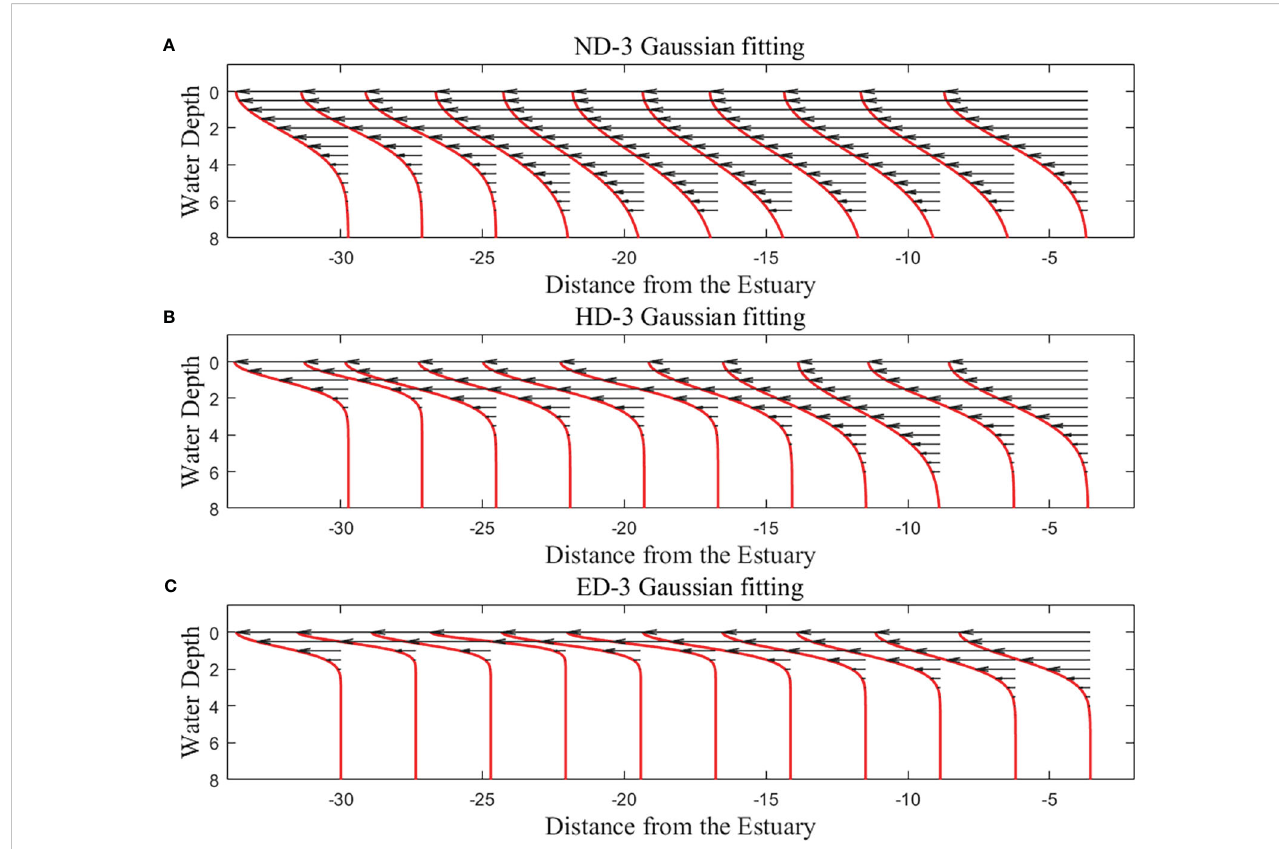
FIGURE 6 Gaussian distribution of horizontal velocity of D-3 groups: Case ND-3 (A) , Case HD-3 (B) and Case ED-3 (C) .